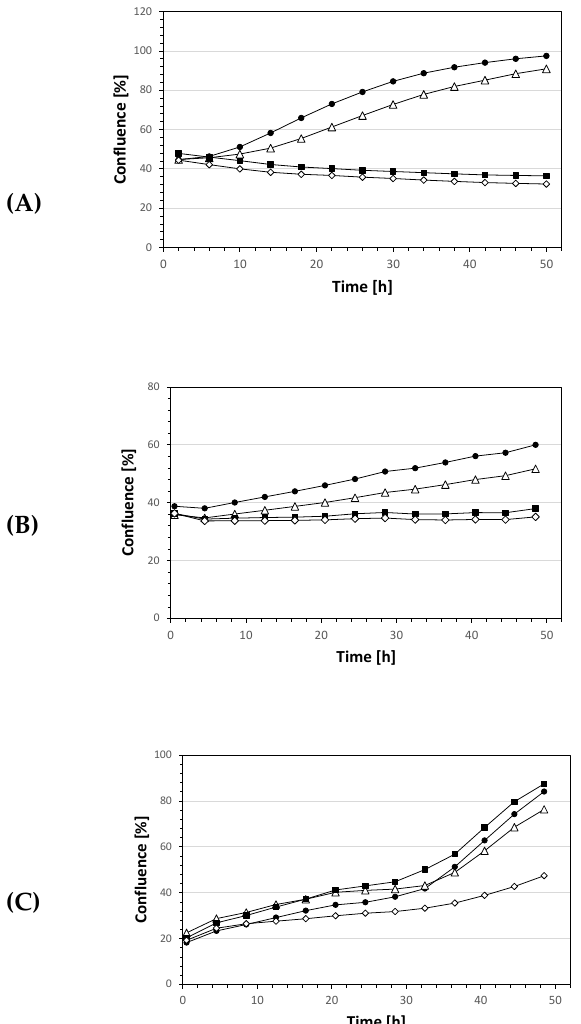
Figure 7. IncuCyte ® cell proliferation assay with di ff erent concentrations of bikaverin used for treating ( A ) MCF7 cells ( B ) A427 cells ( C ) A431 cells. DMSO 1% (black circle), 1 µ M (triangle), 5 µ Figure 7 . IncuCyte® cell proliferation assay with different concentrations of bikaverin used for treating (A) MCF7 cells (B) A427 cells (C) A431 cells. DMSO 1% (●), 1 µM (∆), 5 µM ( ■ ), 10 µM (◊).